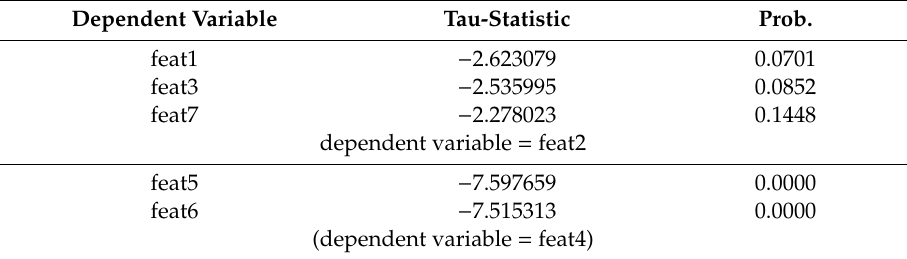
Table 2. The Engle-Grangertest results of energy features.